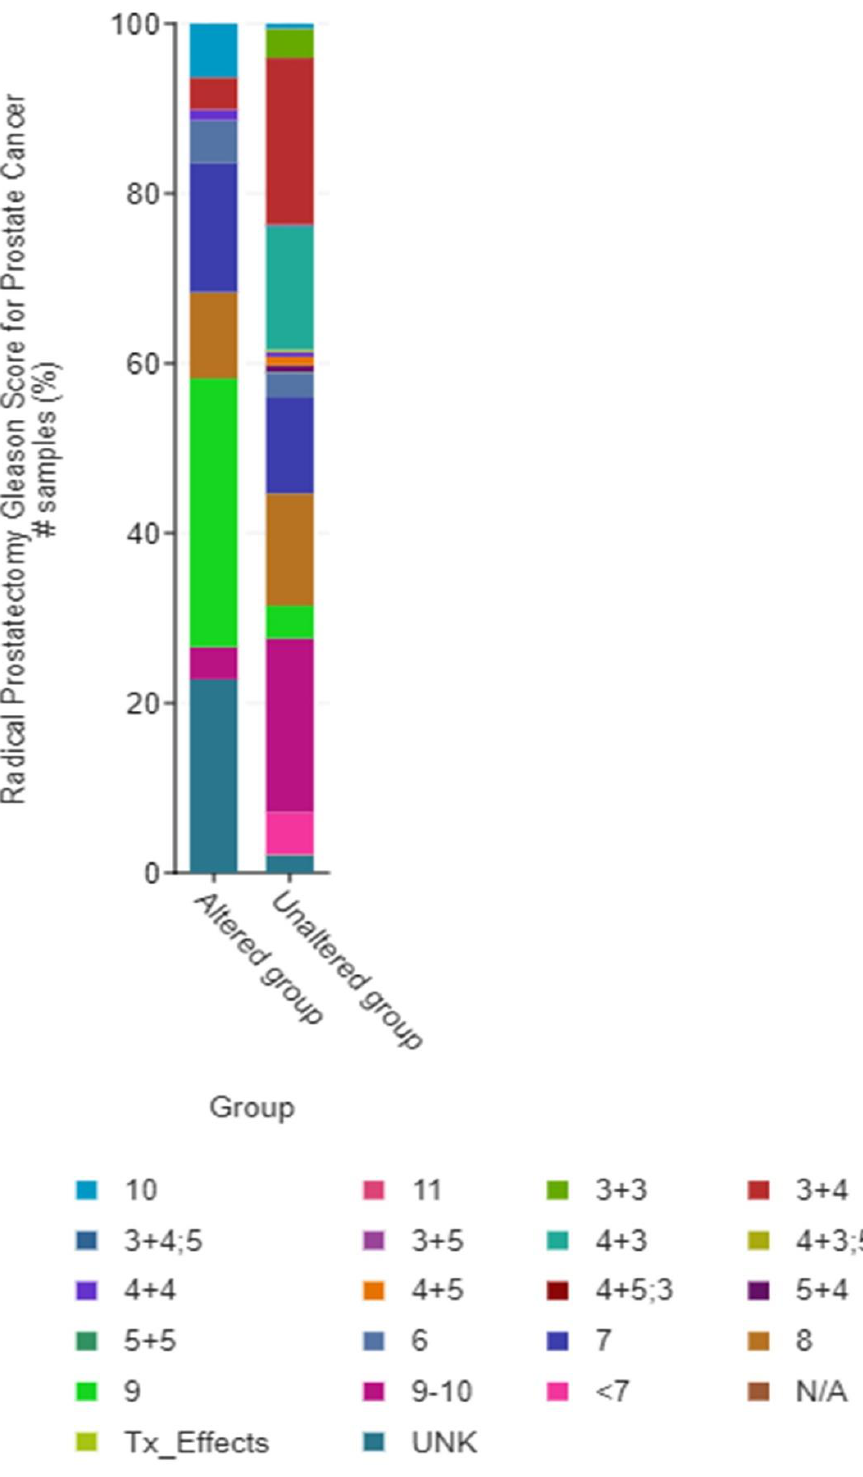
Figure 8. The contribution. Graph of altered and unaltered group.